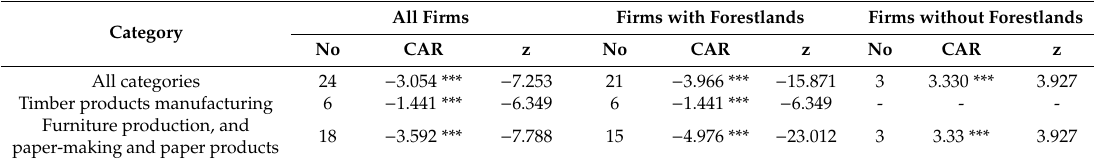
Table 4. Results of testing policy III.